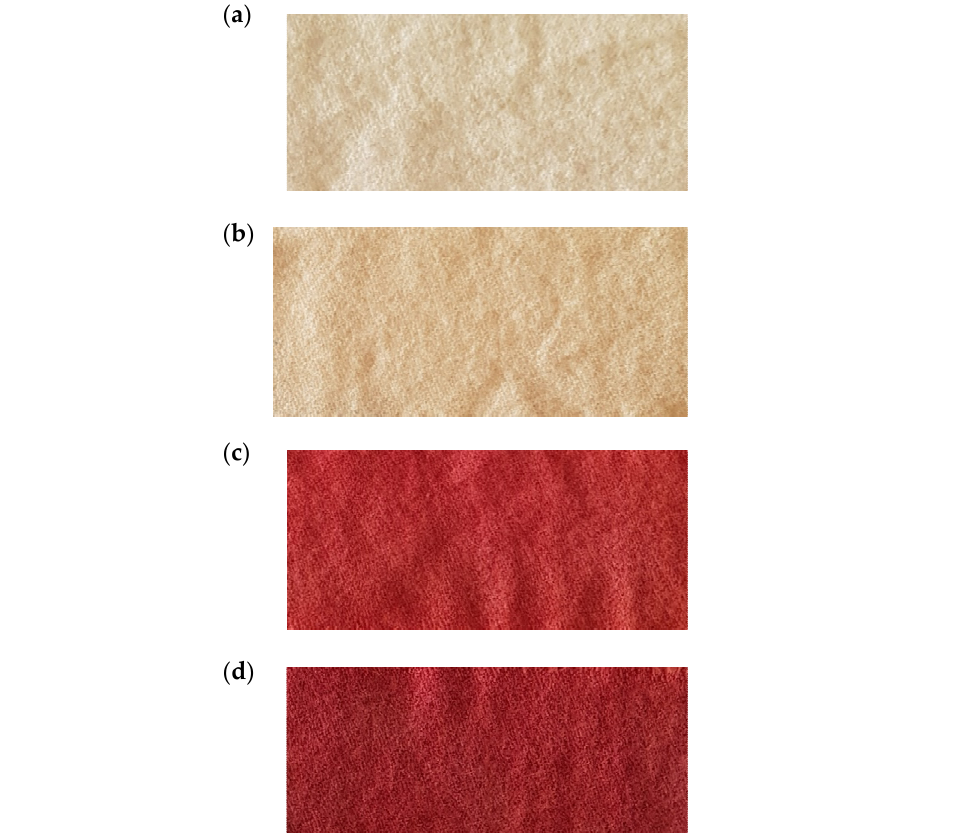
Figure 16. Comparisons between the color characteristics obtained by the functionalizations in acid medium of wool (FAAW) and dye (FAAD).